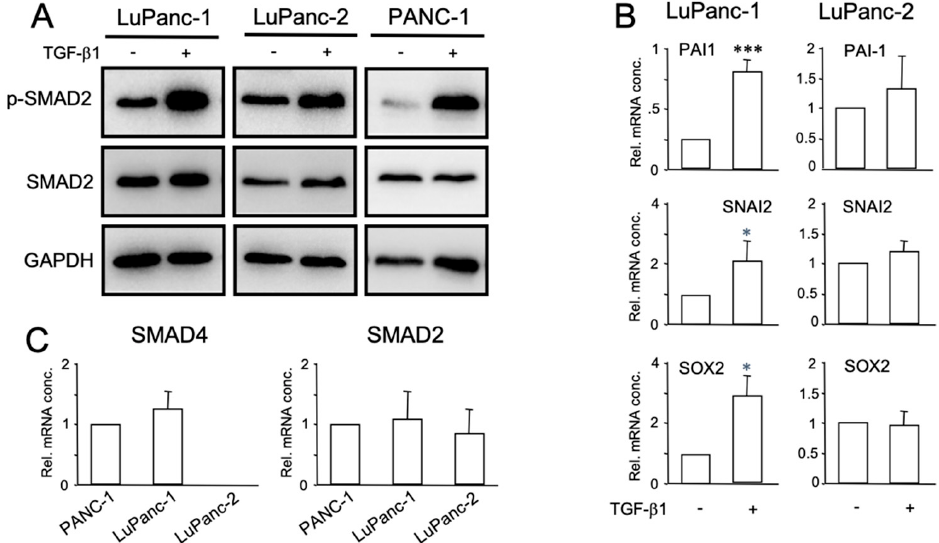
Figure 5. Characterization of TGF- β signaling in LuPanc-1 and LuPanc-2 cells. ( A ) Phospho-immunoblotting of SMAD2 in LuPanc-1, LuPanc-2, and PANC-1 cells as the control. Cells were treated with rhTGF- β 1 for 2 h and subjected to sequential immunoblotting of phospho-SMAD2 (p-SMAD2), (total) SMAD2, and GAPDH to control for equal loading. ( B ) Monitoring of TGF- β target genes for their response to treatment with rhTGF- β 1. LuPanc-1 and LuPanc-2 cells were stimulated short-term (48 h) for PAI-1 and SLUG or long-term (15 d) for SOX2 with rhTGF- β 1 (5 ng/mL) and subjected to qPCR for SERPINE1 , SNAI2 , or SOX2 , respectively. The asterisks ( ∗ ) indicate a significant difference; ∗ p < 0.05, ∗∗∗ p < 0.001. ( C ) Detection of SMAD4 mRNA levels by qPCR in LuPanc-1 and LuPanc-2 cells relative to those in PANC-1 cells set arbitrarily at 1.0. SMAD2 mRNA was detected in the same samples as a positive